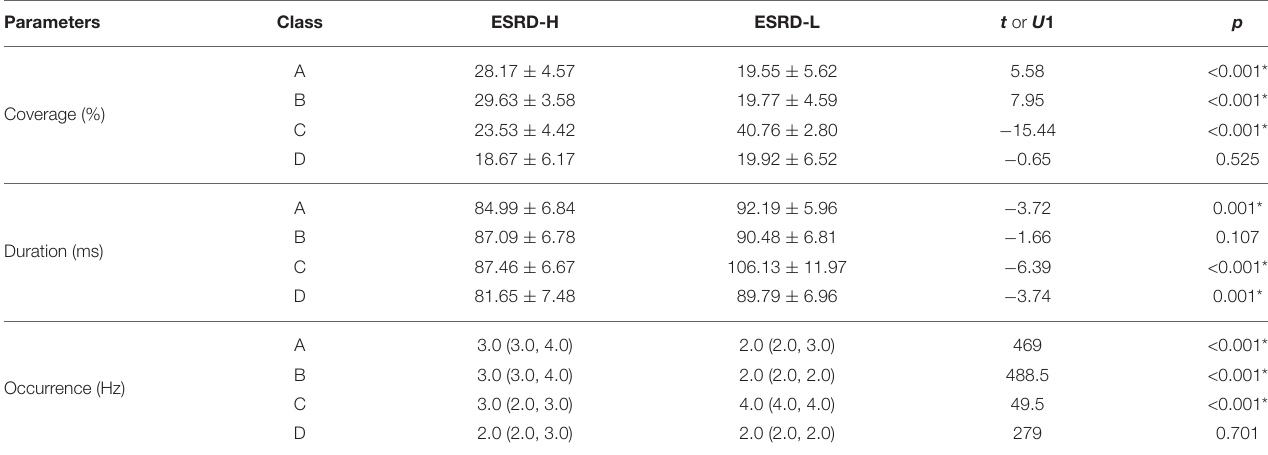
TABLE 3 | Significant differences were observed for most prototypes and